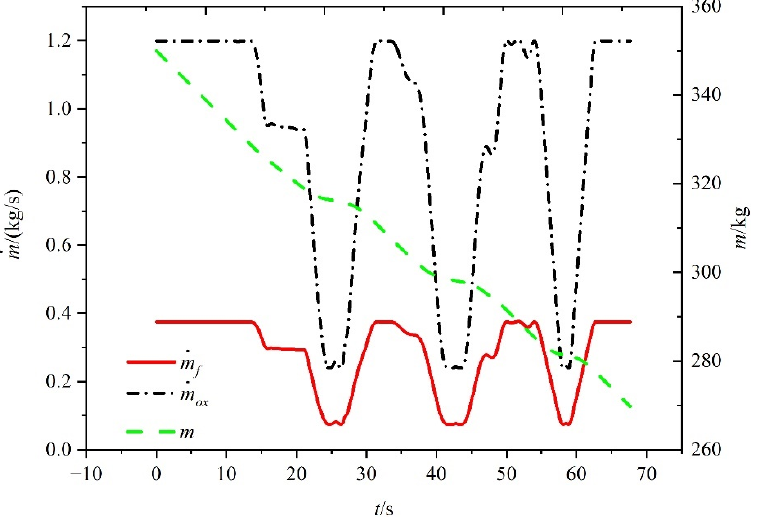
Figure 12. Propellant mass flow rates and vehicle mass in the second scenario vs. time.